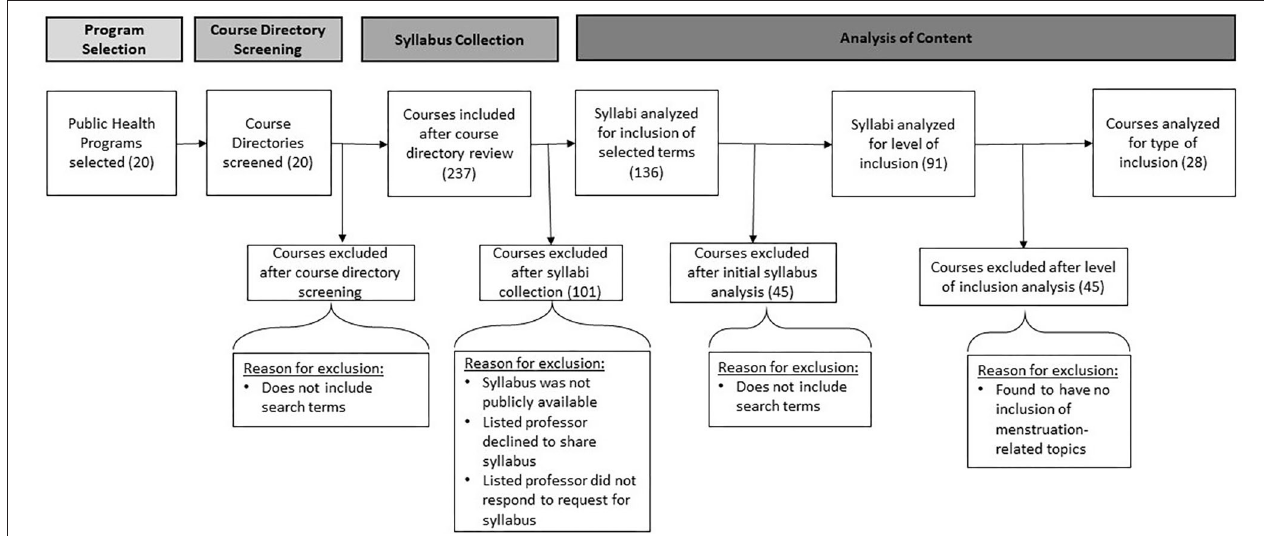
FIGURE 1 | Flow Diagram of Curriculum review and inclusion/exclusion